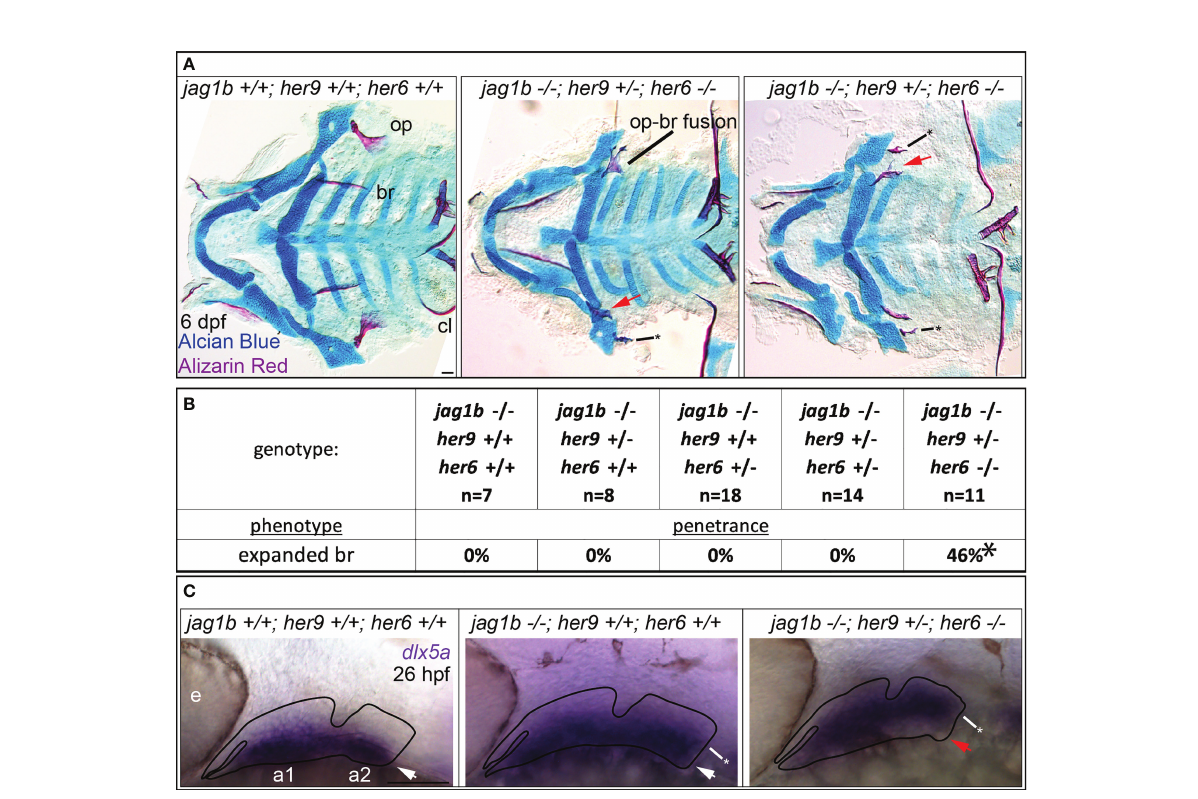
FIGURE 9 jag1b , her9 , and her6 redundantly regulate dorsal versus ventral identity. (A) jag1b ; her6;her9 triple heterozygotes were intercrossed and six days post fertilization (dpf) larvae were stained with Alcian Blue and Alizarin Red to label cartilage and bone. The individuals were then genotyped, the viscerocrania were dissected and fl at mounted then imaged. The opercle (op), branchiostegal ray (br), and cleithrum (cl) are indicated in the wild type control. The bony fusion between the opercle and the branchiostegal ray is indicated. Red arrows indicate expanded, fan-shaped branchiostegal ray. Asterisk marks stick-shaped op phenotype (B) Genotyped preps from A were scored for penetrance of expanded branchiostegal ray. Asterisk indicates that penetrance of this phenotype in jag1b -/-; her9 +/-; her6 -/- is signi fi cantly different from all other genotypes, where it is never observed. (C) jag1b ; her6;her9 triple heterozygotes were intercrossed and 26 hours post fertilization (hpf) larvae were fi xed for in situ hybridization experiments to label dlx5a expression. White arrows indicate ventral dlx5a expression, asterisks mark dorsally expanded dlx5a expression. Red arrow indicates reduced ventral dlx5a expression in triple mutants suggesting ventral-versus-dorsal identity reversal. This phenotype was observed on both sides of in 3/3 embryos examined with this genotype. Scale bars are 50 m